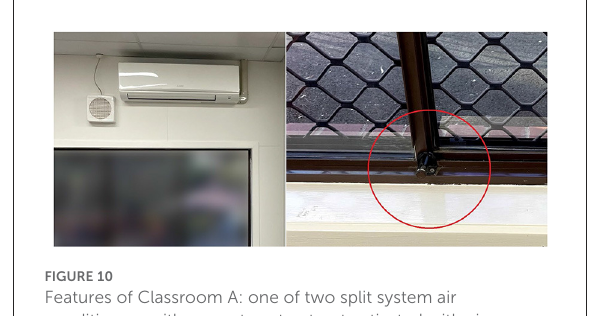
FIGURE10 Features of Classroom A: one of two split system air conditioners with separate extract not activated with air conditioner start-up and example of bolts fitted to